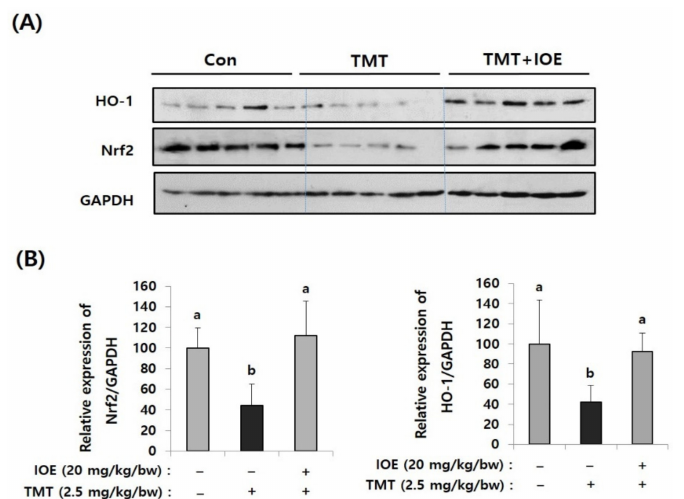
Figure 6. TMT-mediated suppression of nuclear factor erythroid 2-related factor 2 (Nrf2) and heme oxygenase-1 (HO-1) in mouse brain was recovered by IOE. Expression levels of Nrf2 and HO-1 in the brains of each mouse group were measured by Western blotting ( n = 5) ( A ). The density of each band was estimated by the ImageJ program and the relative expressions of Nrf2 (Nrf2/GAPDH) and HO-1 (HO-1/GAPDH) were calculated and tabulated ( B ). Data shown are means ± SD. Con: control (non-treated). a: significant differences ( p < 0.05) when compared with b.